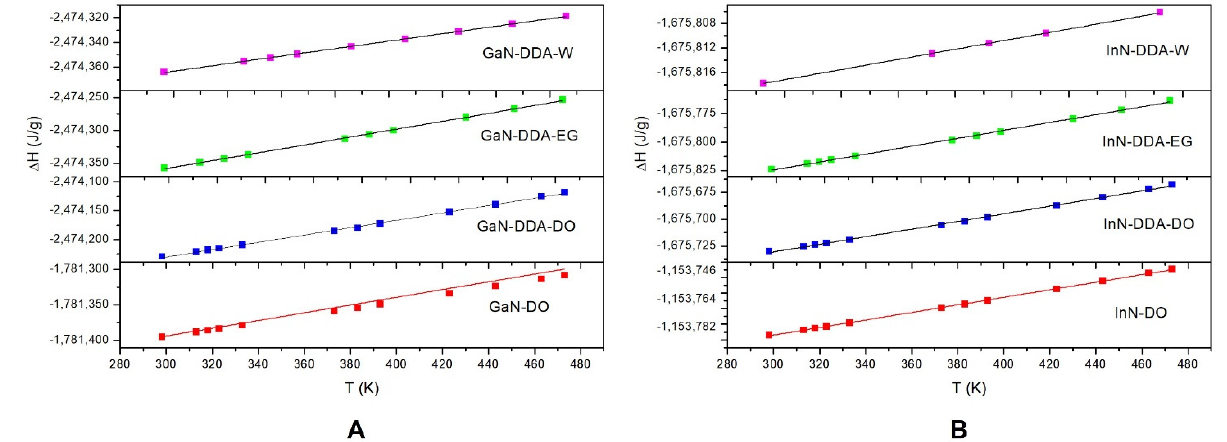
Figure 7. Plot of the enthalpy versus temperature for the GaN ( A ) and InN ( B ) systems in the presence of water (W), ethylene glycol (EG), and diphenyl oxide (DO) as solvents.